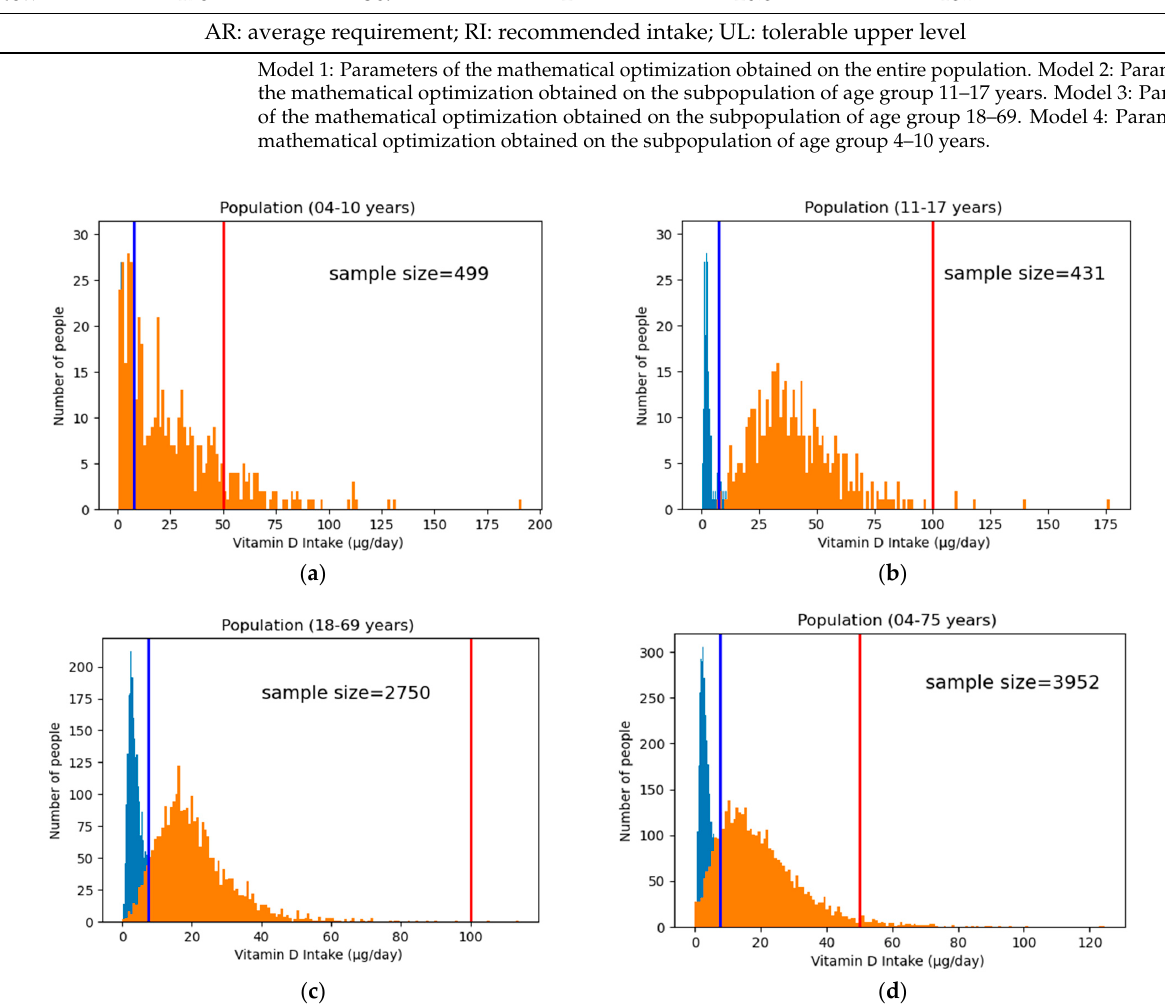
Figure 1. Population distribution of vitamin D intake of the four models trained on their respective age groups. The blue histogram represents the current vitamin D intake, whereas the orange histo- gram represents the new intake after fortification. The blue vertical line shows the AR, and the red line shows the UL: ( a ) intake distribution of Model 4 trained on the age group 4–10 years; ( b ) intake distribution of Model 2 trained on the age group 11–17 years; ( c ) intake distribution of Model 3 trained on the age group 18–69 years; and ( d ) intake distribution of Model 1 trained on the entire population age group 4–75 years.